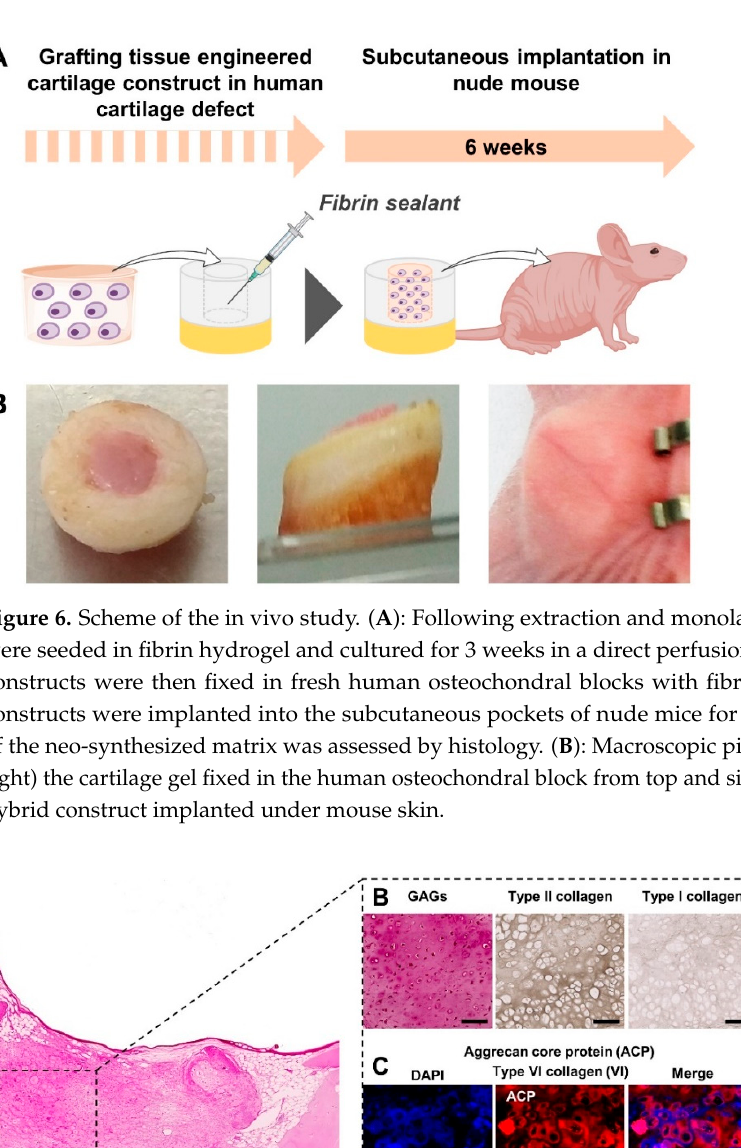
Figure 7. The cartilage construct remains stable after 6 weeks of subcutaneous implantation in nude mice. Following 21 days of culture in a bidirectional perfusion bioreactor in the presence of BIT, fibrin hydrogels seeded with HACs were placed into a cartilage defect made in human osteochondral blocks and then implanted into the subcutaneous pockets of nude mice. ( A ): hematoxylin and eosin staining of the cartilage construct in the defect after 6 weeks of subcutaneous implantation. ( B , C ): Immunohistochemical analyses of the implant. ( B ): Cartilage implant stained for safranin-O fast green (GAGs) as well as for collagen types I and II. ( C ): Aggrecan core protein and type VI collagen immunofluorescence staining of the cartilage graft. Proteins of interest were stained with the Alexa Fluor 488-conjugated secondary antibody (red). Nuclei were stained with Hoechst dye (blue) (scale bars: A = 1 mm, B-C = 100 µ